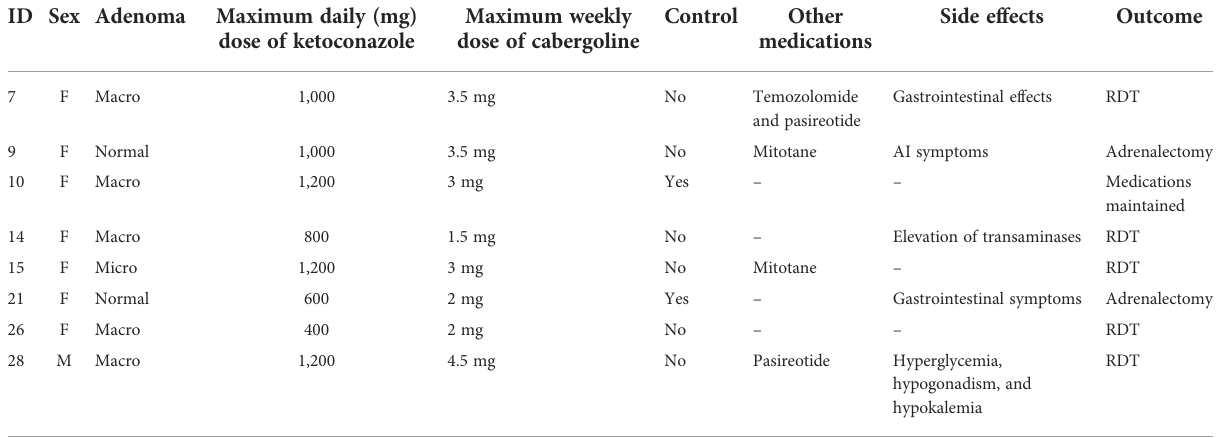
TABLE 7 Effects of associating cabergoline with ketoconazole in Cushing ’ s disease patients. ID Sex Adenoma Maximum daily (mg) dose of